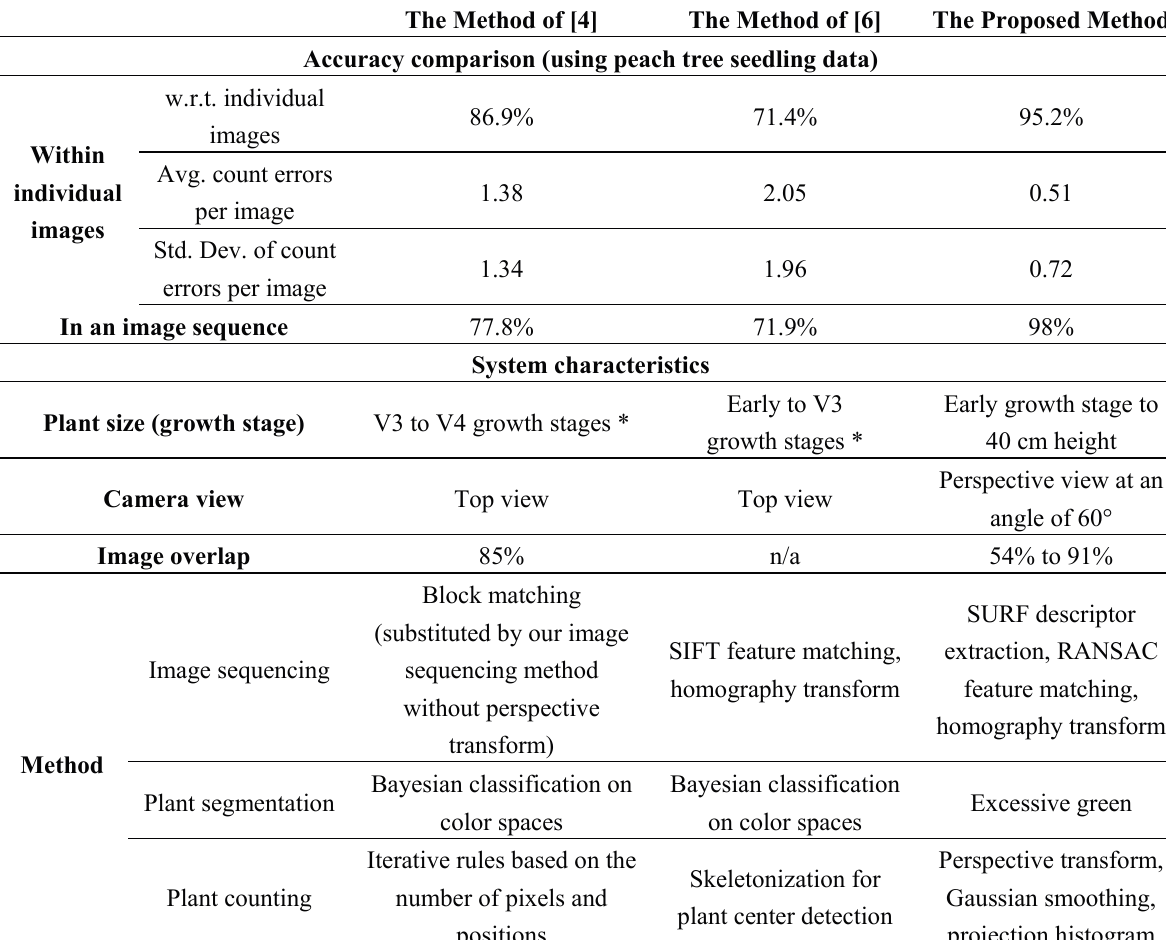
Table 3. Accuracy and system characteristics comparison of the proposed method to